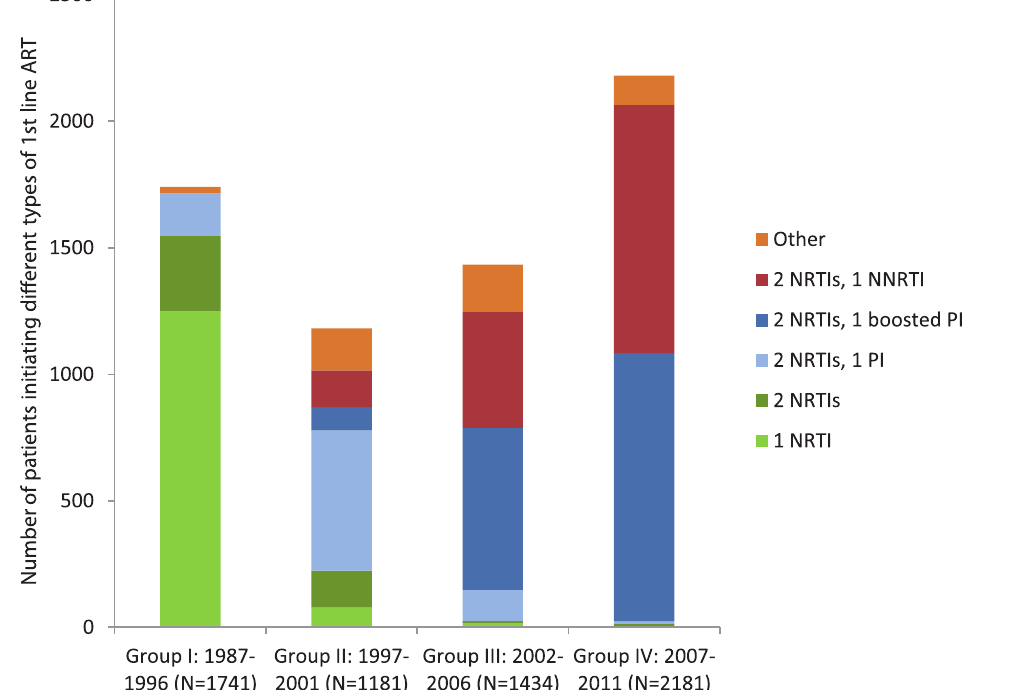
Figure 2. Differences in first line ART combinations over time. The coloured bars show the total number of patients in groups I–IV who initiated different kinds of first line ART: 1 NRTI only; 2 NRTIs; 2 NRTIs + 1 (unboosted) PI, 2 NRTIs + 1 boosted PI, 2 NRTIs + 1 NNRTI or Other